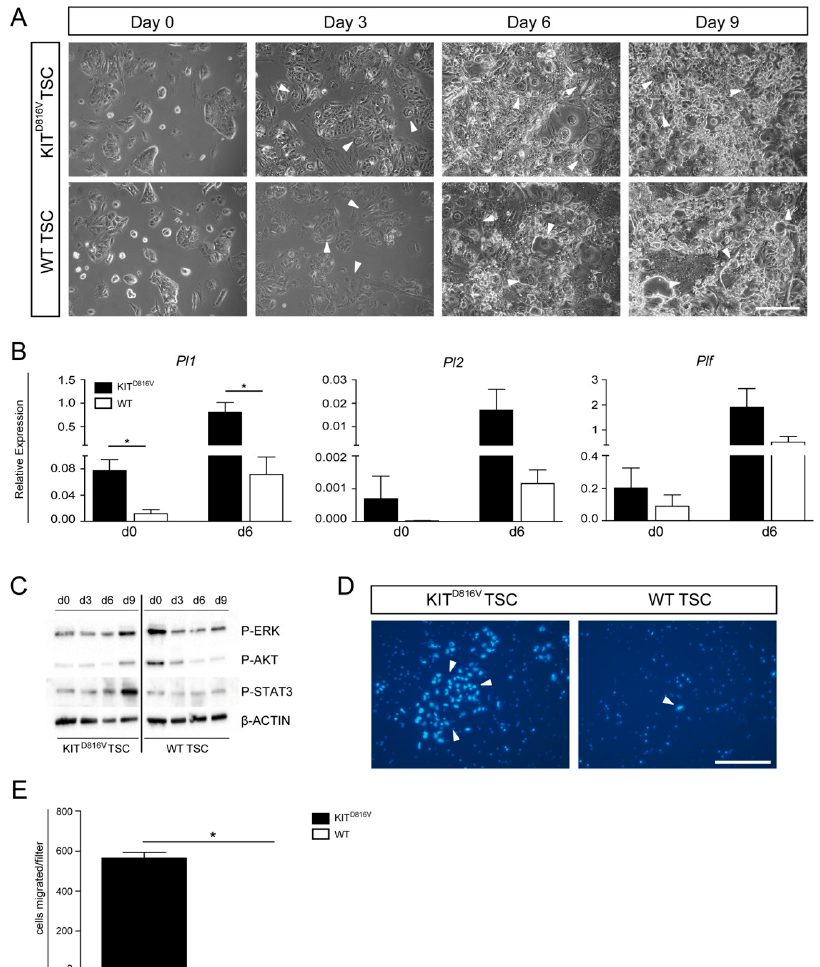
Figure 5. Differentiation of KIT D816V -TSC: ( A ) Photomicrographs depicting in vitro differentiation of KIT D816V -TSC line #3 and WT-TSC line 2.1 cultured for 0, 3, 6, and 9 days under differentiation conditions. White arrows indicate TGCs. Scale bar represents 250 μ m. ( B ) qRT-PCR analysis of endogenous expression of Pl1 , Pl2 , and Plf in KIT D816V -TSC line #3 and WT-TSC line 2.1 in undifferentiated states and after culture under differentiation conditions for 6 days. RNA was obtained from three biological replicates; expression was normalized to the housekeeping gene Gapdh. Data is represented by mean value ± SD. Significance was determined by unpaired t-test and indicated with * p < 0.05. ( C ) Western Blot detected phosphorylated Extracellular-Signal Regulated Kinase (ERK), Protein Kinase B (AKT), and Signal Transducers and Activators of Transcription 3 (STAT3) during differentiation of KIT D816V -TSC line #3 and WT-TSC line 2.4 in comparison to β -ACTIN. ( D ) Representative photomicrographs of Hoechst-stained nuclei of cells that invaded through Matrigel coated filter membranes after five days under differentiating conditions: White arrows indicate nuclei of TGCs. Scale bar represents 250 μ m. ( E ) Quantification of invaded cells per filter in KIT D816V -TSC line and WT-TSC line (biological replicates = 2): Data is represented by mean value ± SD. Significance was determined by unpaired t-test and indicated with * p < 0.05.